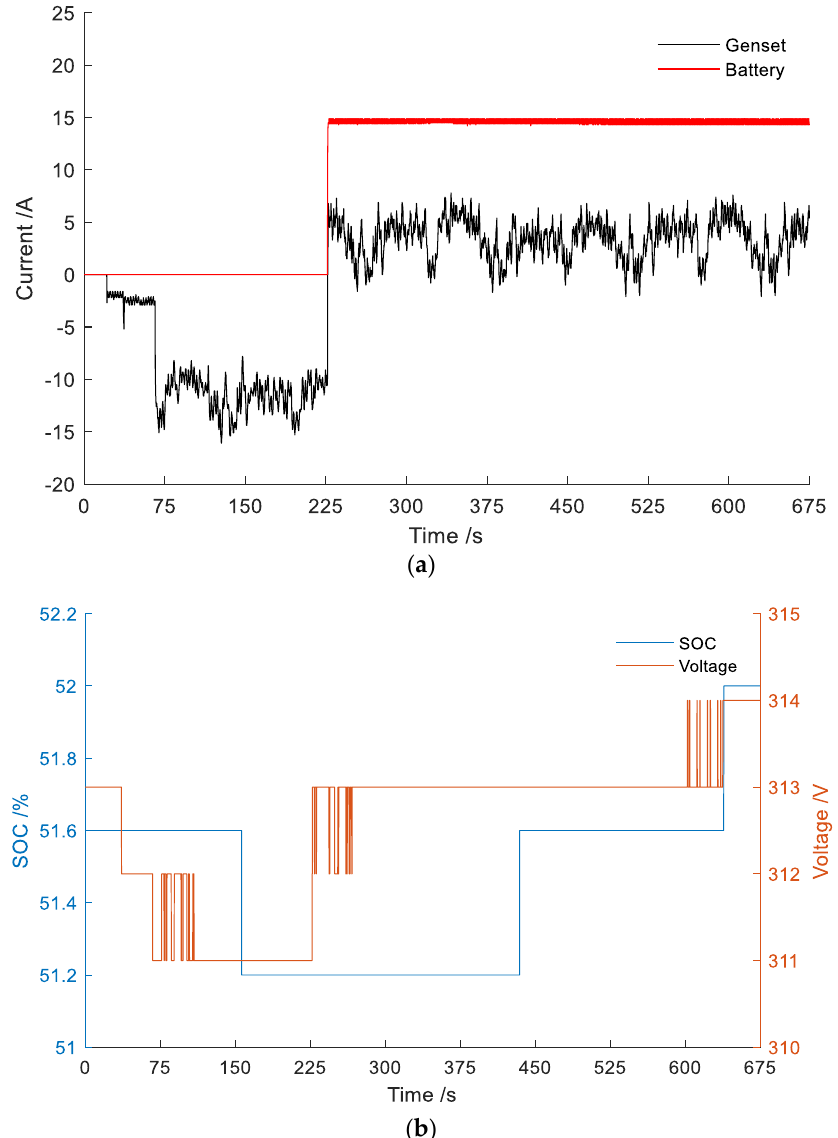
Figure 10. The experimental results of the battery pack characteristic under the rotary tillage oper- ation: ( a ) battery current and generator-set charging current; and ( b ) battery voltage and state of charge